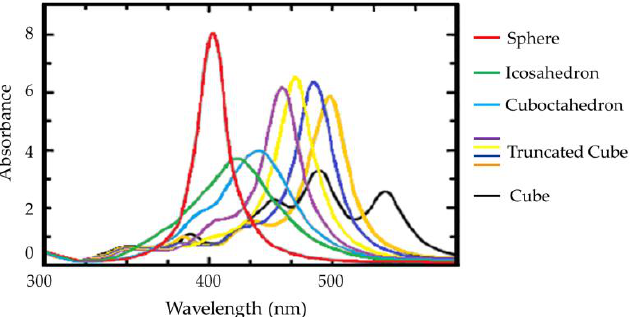
Figure 7. UV–Vis spectra for gold nanoparticles of different shapes.